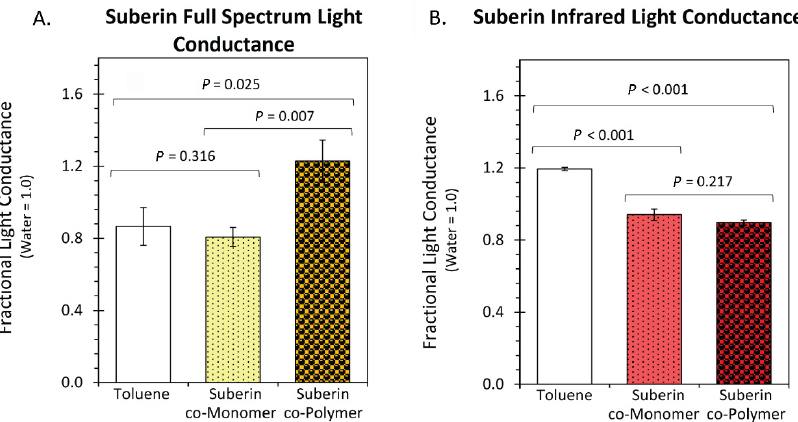
Figure 7. Light transmission graphs for full spectrum light Panel ( A ) and infrared light Panel ( B ) compare fractional transmission values for toluene solvent and 0.5 mM solutions of the suberin co ‐ monomers and co ‐ polymer. All data reflects average values ± SE for N = 6 replicates. p ‐ values are shown in each panel showing levels of significance. p < 0.05 was considered statistically significant.